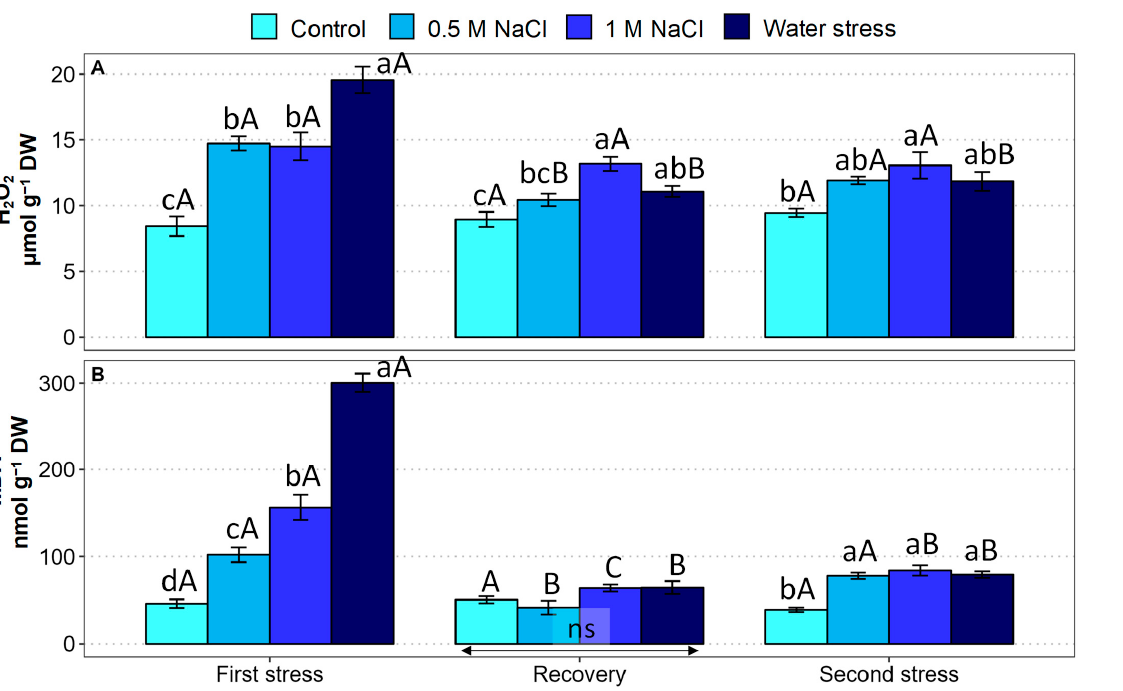
Figure 6. Effect of 30 days of stress treatment (First stress), followed by 15 days of watering with non ‐ saline water (Recovery) and by additional 15 days of stress (Second stress) on leaf concentration of oxidative stress markers in Limonium angustebracteatum plants. ( A ) Hydrogen peroxide (H 2 O 2 ) and ( B ) Malondialdehyde (MDA). Different lowercase letters over the bars indicate significant dif ‐ ferences between treatments (Control, 0.5 M NaCl, 1 M NaCl, and Water stress) for each sampling, at p ≤ 0.05; ns: non ‐ significant. Different uppercase letters indicate significant differences between the three sampling times (First stress, Recovery, and Second stress) for each treatment, at p ≤ 0.05; ns: non ‐ significant. Vertical bars indicate standard error (n = 4). As expected, the generation of oxidative stress under conditions of salinity and water stress induced the synthesis of common antioxidant metabolites, phenolic compounds (TPC), including the subgroup of flavonoids (TF) (Figure 7).